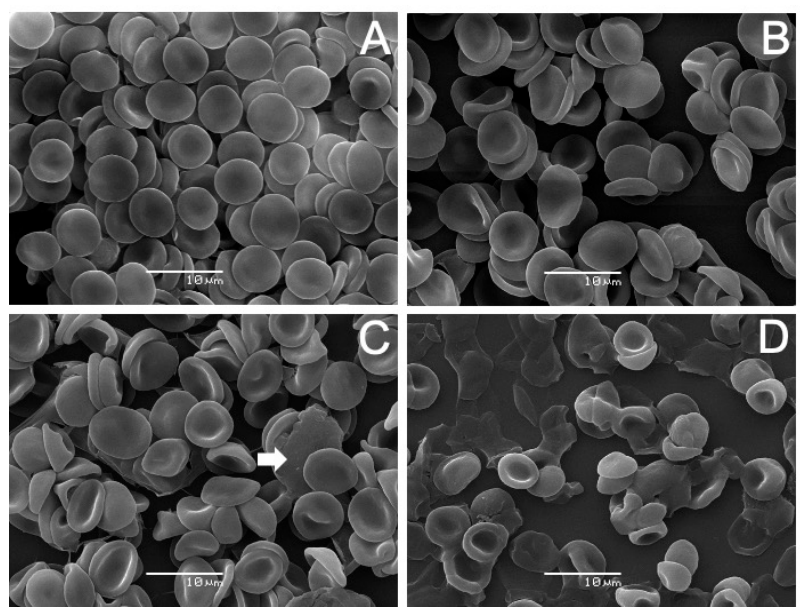
Figure 8. A β (1-42) effect on the morphology of human erythrocytes. Images obtained by scanning electron microscopy (SEM) of ( A ) Control, ( B ) 5 µ M, ( C ) 10 µ M, and ( D ) 20 µ M A β (1-42). Arrow in Figure 8C highlights an erythrocyte membrane fragment.